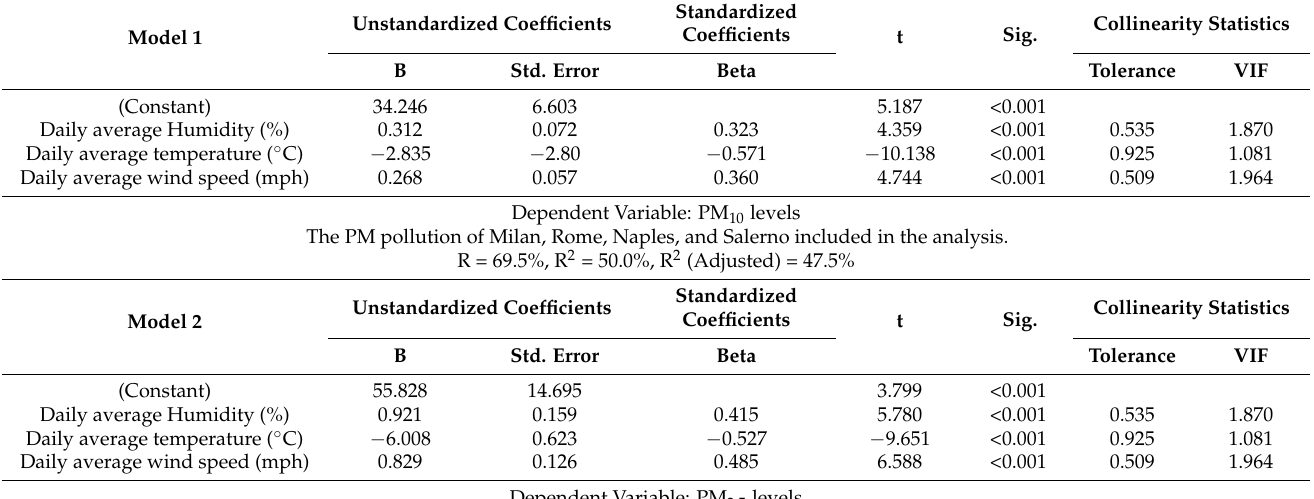
Table 5. Total COVID-19 cases and the daily average of new COVID-19 cases in Milan, Rome, Naples, and Salerno (January